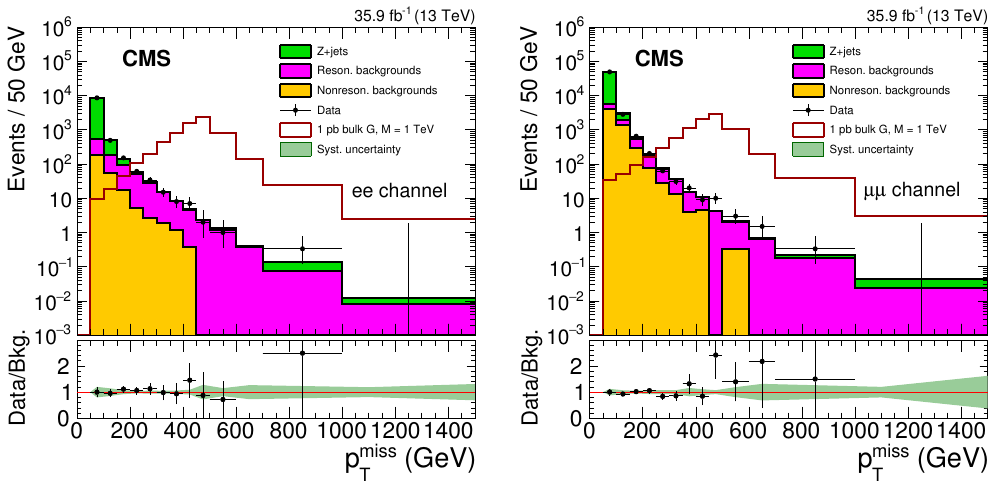
Figure 3 . The p miss for electron (left) and muon (right) channels comparing the data and back- T ground model based on control samples in data. The expected distribution for a zero width bulk graviton resonance with a mass of 1 TeV is also shown for a value of 1 pb for the product of cross section and branching fraction (cid:27) (pp ! X ! ZZ) B (ZZ ! 2 ‘ 2 (cid:23) ). The lower panels show the ratio of data to the prediction for the background. The shaded band shows the systematic uncertainties in background, while the statistical uncertainty in the data is shown by the error